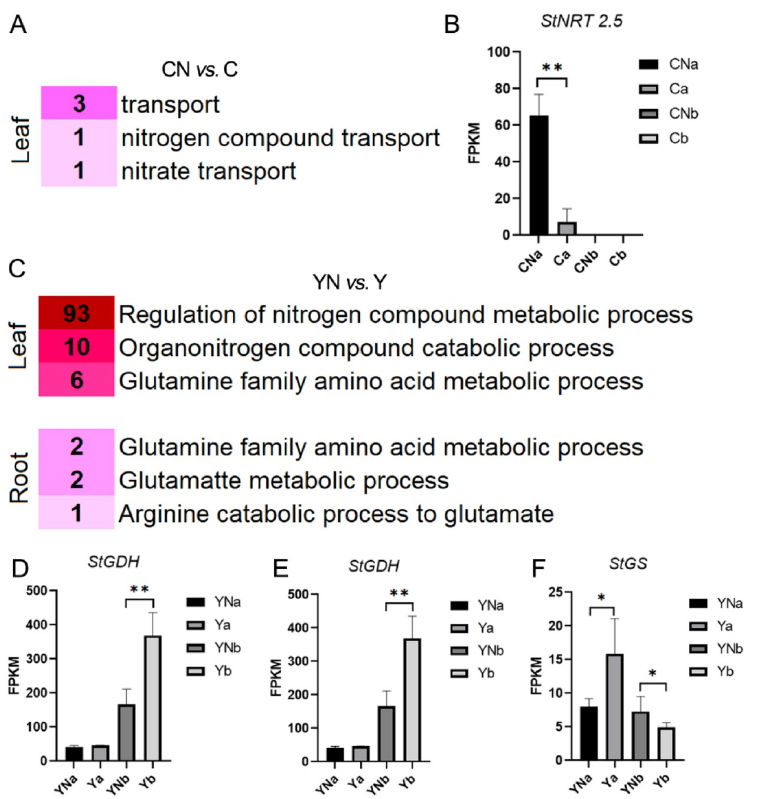
Fig 5. The biological processes associated with N metabolism in the leaf and root in three cultivars in response to N deficiency. A, the biological processes associated with N metabolism in the leaf of cultivar C in response to N deficiency. B, the biological processes associated with N metabolism in the leaf and root of cultivar Y in response to N deficiency. The number ahead of the processes indicated gene number enriched in this process. N = 3, �� and � means p < 0.01 and p < 0.05, respectively. A and b are short for leaf and root, respectively. Y, X and C indicate the cultivar of “Yanshu 4”, “Xiabodi” and “Chunshu 4”, respectively. N means treatment with N containing fertilizer (control). For example, YN and Y means “Yanshu 4” treated with N-containing and N-deficiency fertilizer, respectively.